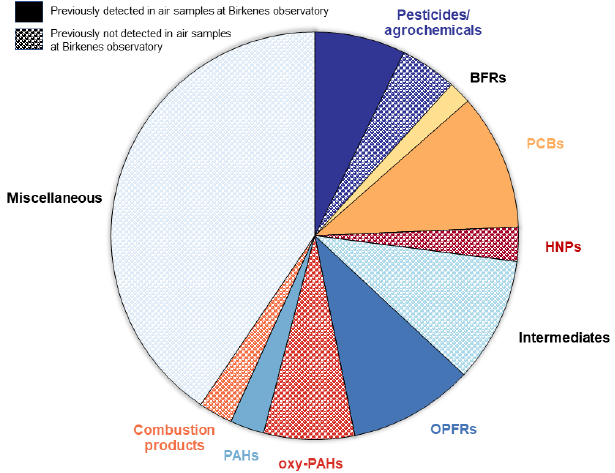
Figure 5. Overview of detected compounds confirmed with refer- ence standards (L0 and L1) and probable structures